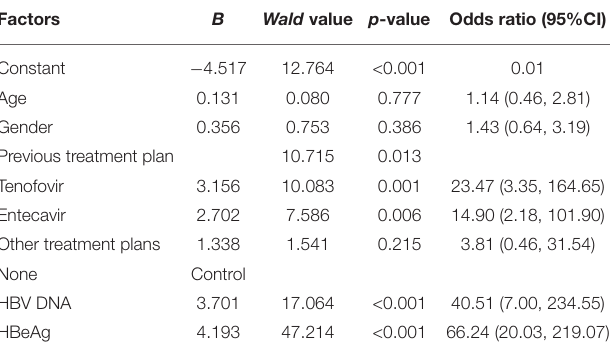
TABLE 2 | Multivariate logistic regression analysis results of baseline pgRNA influencing factors.